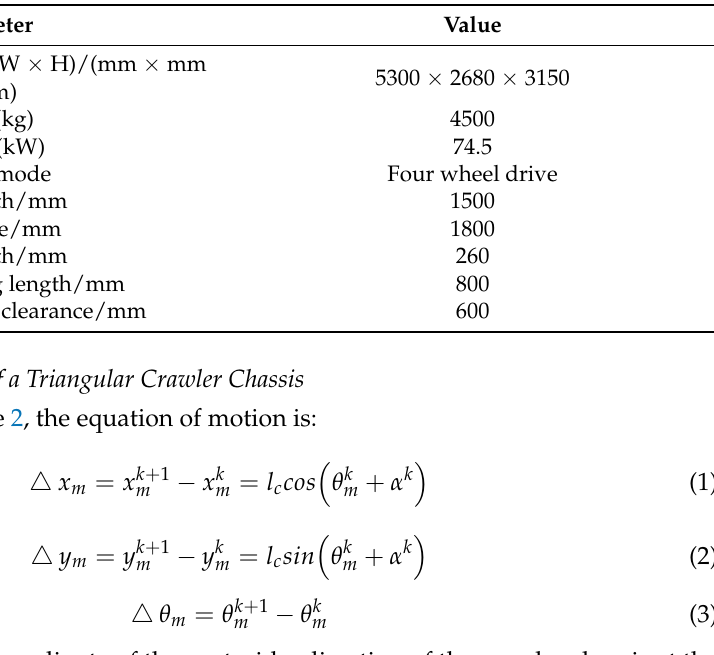
Table 1. Main technical parameters of triangular crawler chassis for ratooning rice harvester.